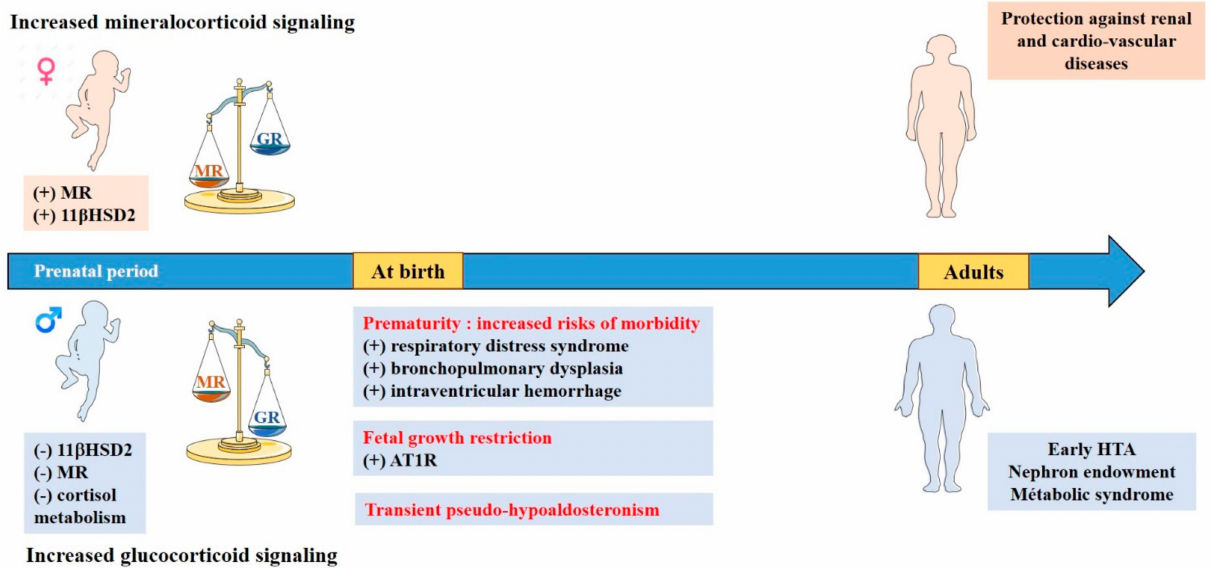
Figure 3. Sexual dimorphism of corticosteroid signaling during kidney development and consequences in pathophysiology. Sexual dimorphism of corticosteroid signaling is effective as early as the perinatal period with higher MR expression and 11 β HSD2 activity in females and higher cortisol metabolism in males, thus favoring mineralocorticoid signaling in female fetus and neonates, and preferential activation of the glucocorticoid pathway in males. These imbalances may have an impact under certain pathophysiological conditions with a higher susceptibility for males to develop short and long term consequences after exacerbated activation of perinatal glucocorticoid signaling